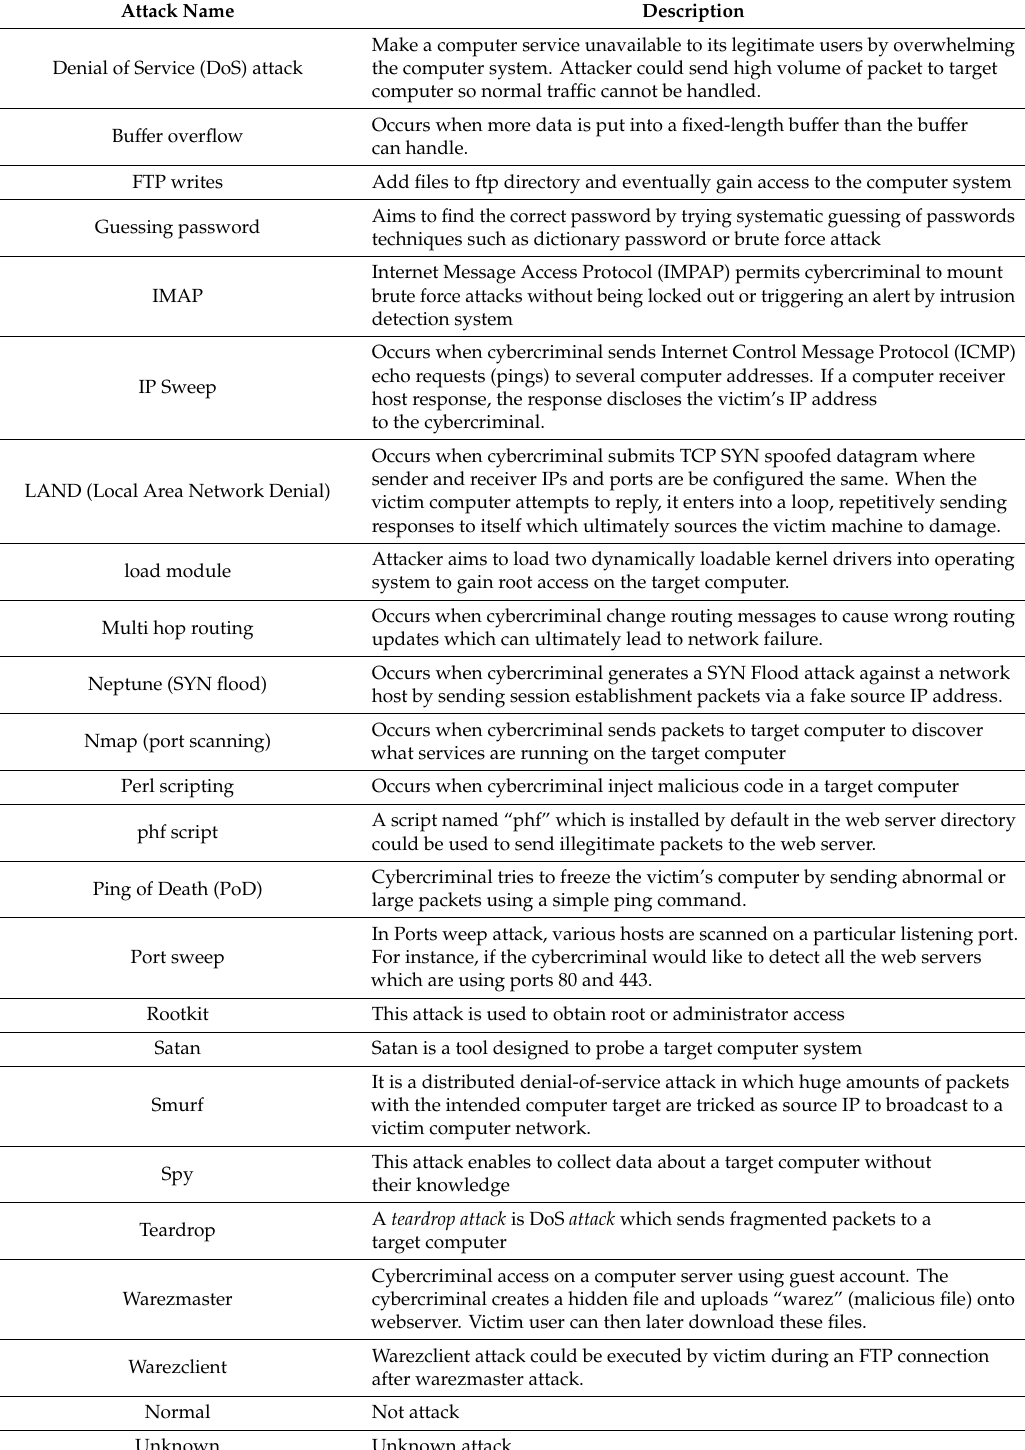
Table 5. List of attacks presented in NSL-KDD